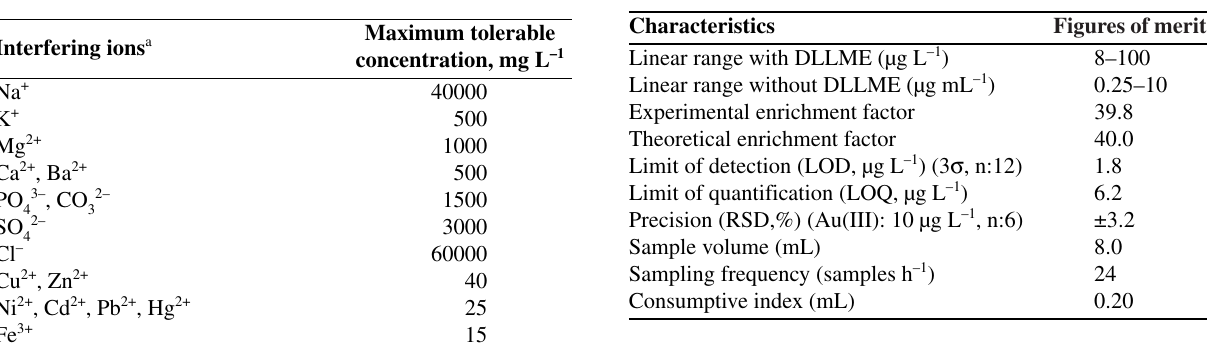
Table 6. Analytical figures of the IP-DLLME-MIS-FAAS method for determination of gold